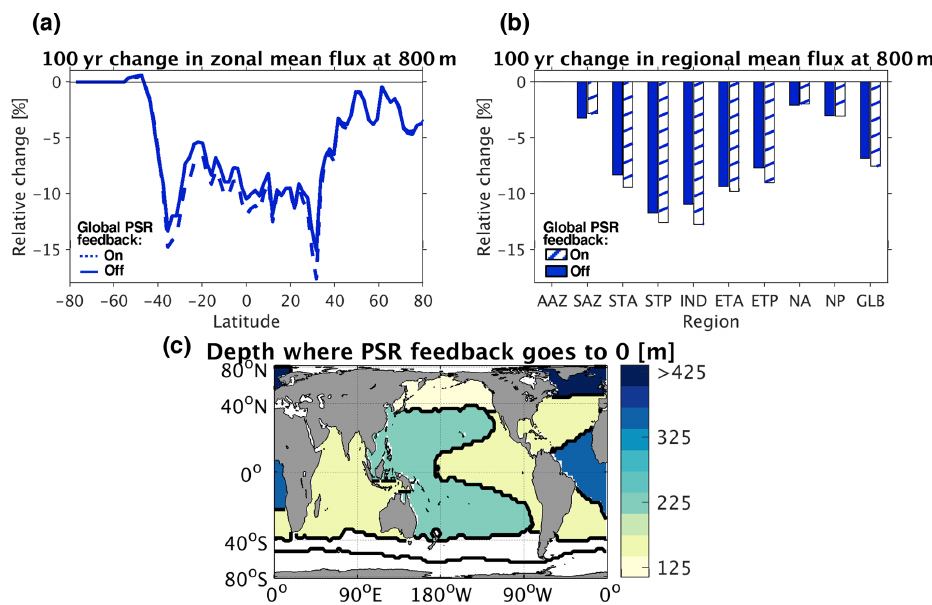
Figure 9. (a) Relative changes in zonal mean particulate organic carbon (POC) flux at 800m depth (725m below the bottom of the euphotic zone) 100 years after decreasing circulation rates by 10%. (b) Same as (a) but with regional and global (GLB) means. (c) Map of regional mean depths below the surface at which the PSR feedback effect flips from negative to positive. In the North Atlantic, the regional mean PSR feedback effect flips from negative to positive at ∼ 2100m depth, which is off the color